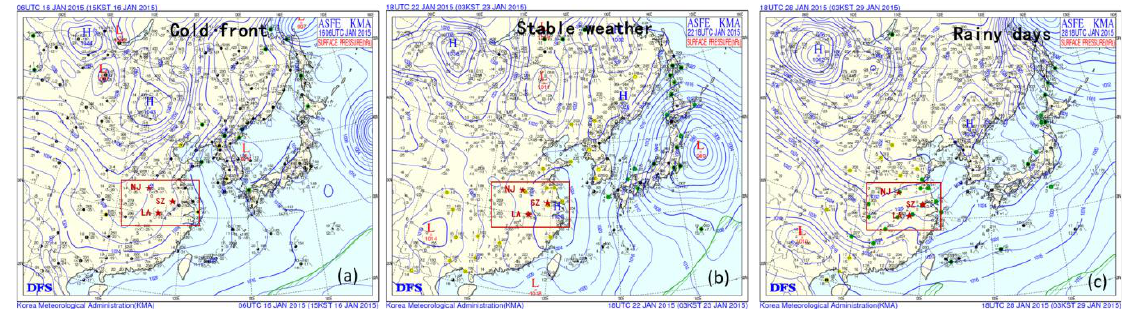
Figure 1. Surface weather patterns and locations of the sampling sites (the red square area represents the YRD, and the red stars represent the sampling sites).